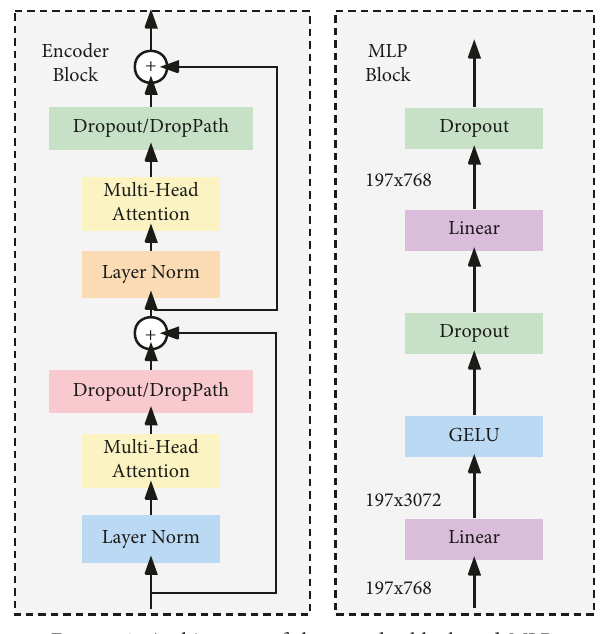
Figure 2: Architecture of the encoder block and